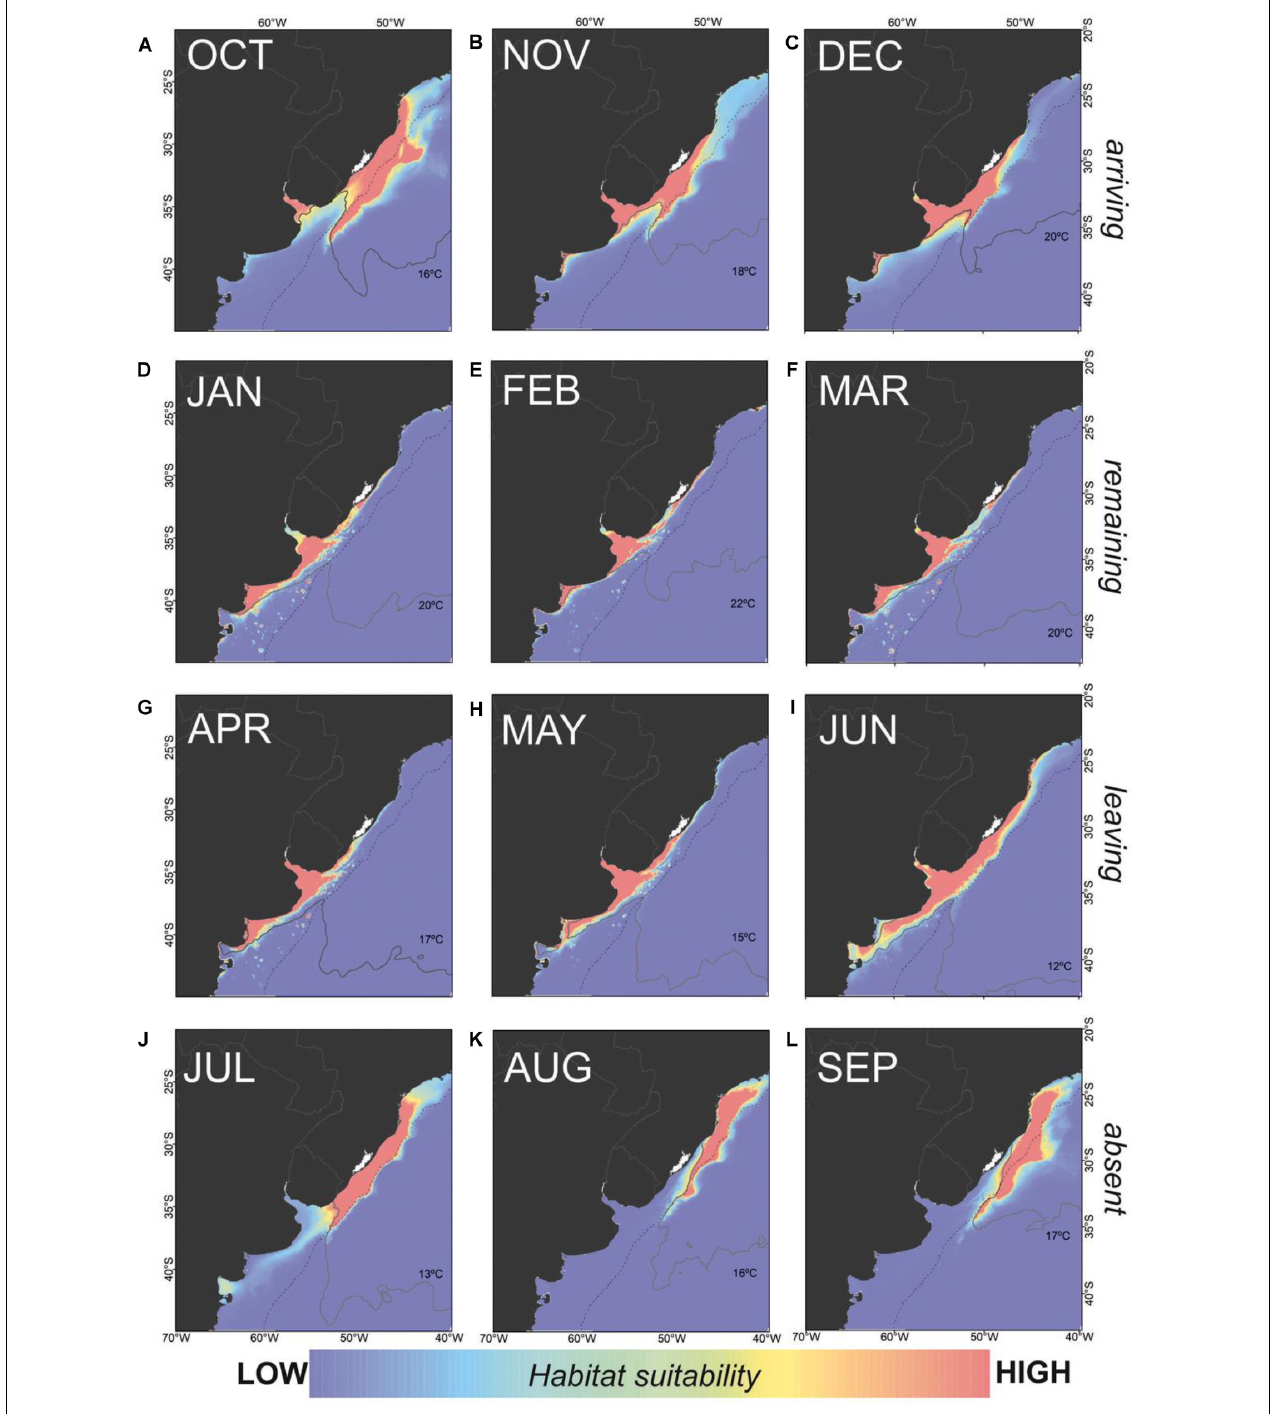
FIGURE 5 | Green sea turtle ( Chelonia mydas ) monthly habitat suitability throughout the year in its boundary range of the SWAO. C. mydas behavior is divided in periods as: (A–C) arriving, (D–F) remaining, (G–I) leaving, and (J–L) absent. Dashed black line indicates 200 m isobath.